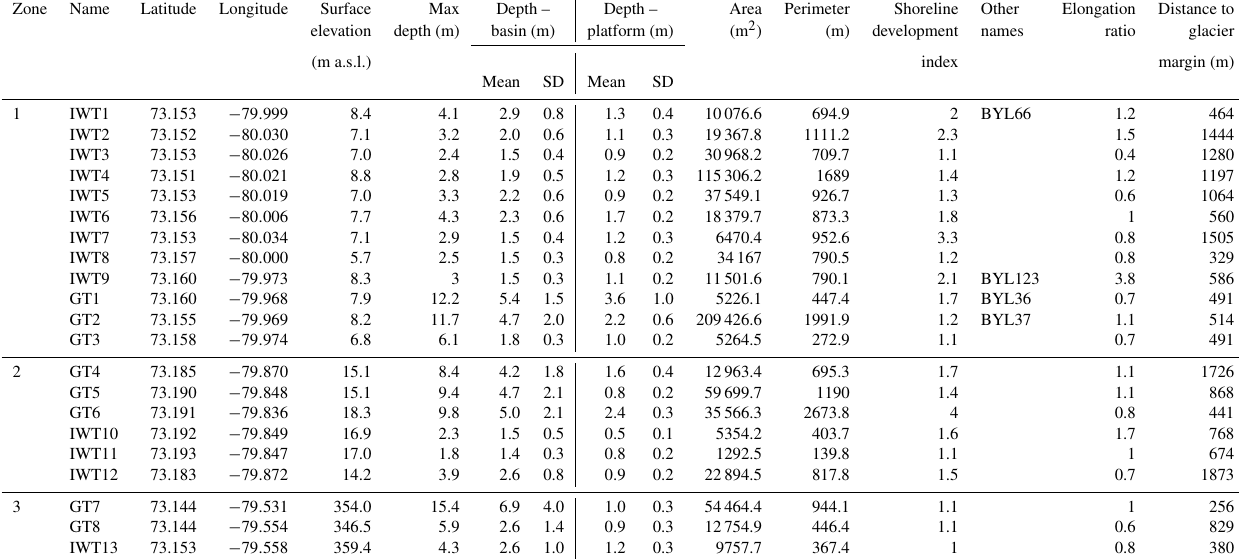
Table 1. Characteristics of lakes ( n = 21) for which bathymetric data were collected in 2015. Zone